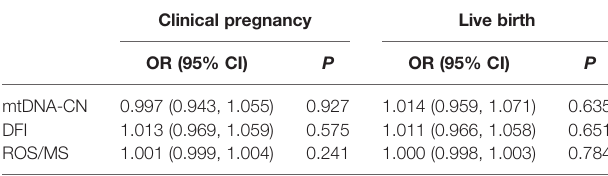
TABLE 4 | Pregnancy outcomes of patients with embryo transfer. Clinical